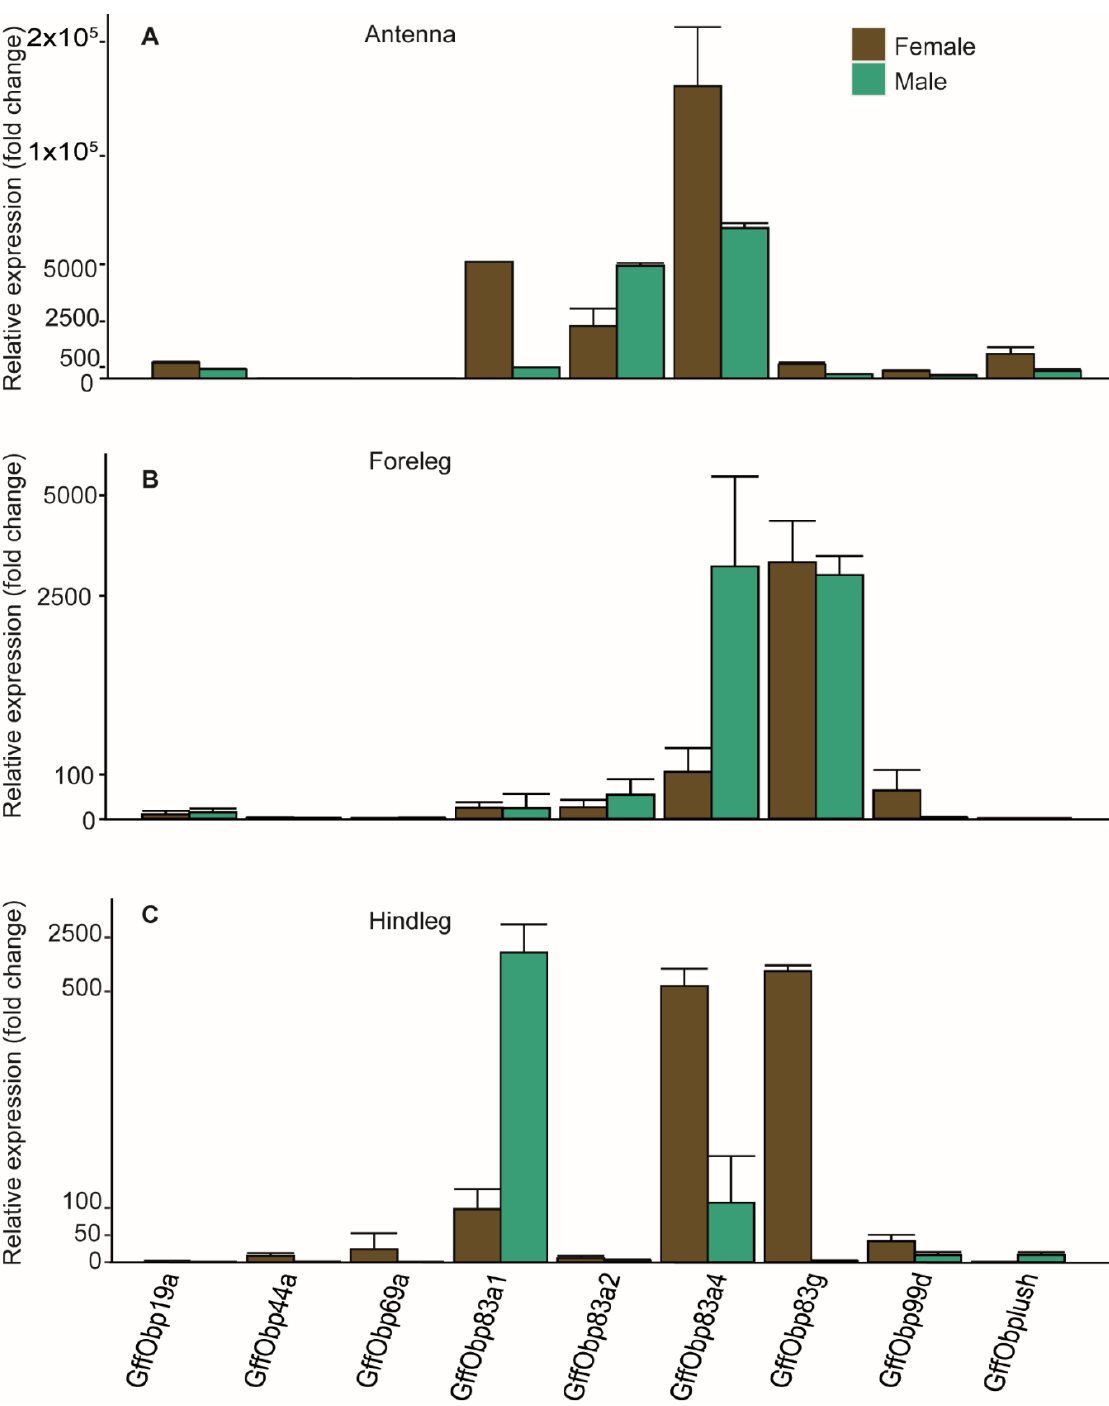
Figure 3. Tissue and sex-specific expression of odorant-binding proteins in antennae and legs using RT-qPCR. B-actin was used as an internal control to normalize the data, and the 2 −ΔΔ CT method [79] was used to calculate the expression level. Bars represent the ± standard error. Given the big variation of expression in different tissues, the graphs are not presented at the same scale. ( A ) Tissue and sex-specific expression of odorant-binding proteins in Antenna ( B ) Tissue and sex-specific expression of odorant-binding proteins in forelegs ( C ) Tissue and sex-specific expression of odorant-binding proteins in hindlegs.